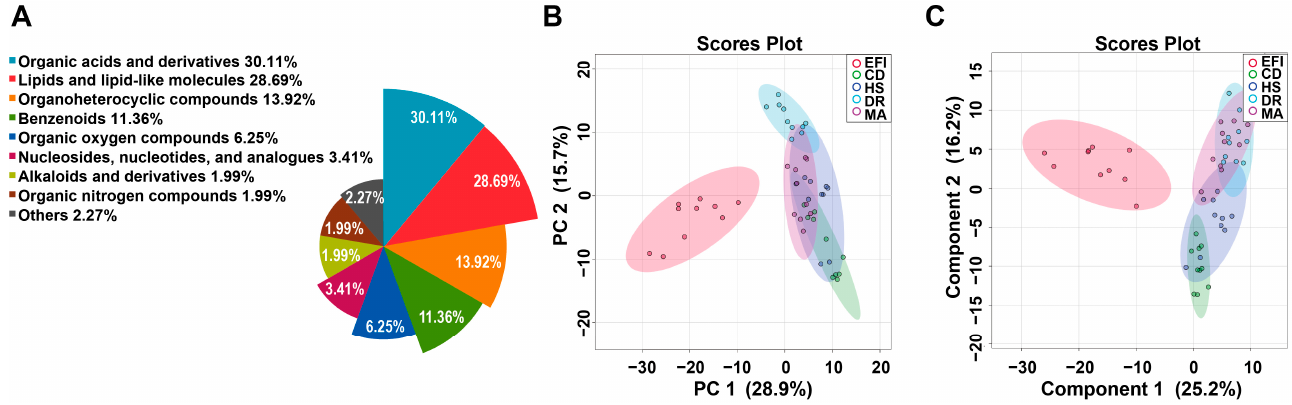
Figure 2. Overviews of the metabolic profiles of plasma samples in the EFI and NDRDs mice. NDRDs, including CD, DR, MA, and HS, are four animal models. n animal = 10, respectively. Total 50 samples in 5 groups. ( A ) Nightingale Rose Chart of metabolite classification. ( B ) Overview of metabolic profiles of the EFI and NDRDs groups using principal component analysis (PCA) score plot. ( C ) The partial least squares discriminant analysis (PLS-DA) score plot. Abbreviations: NDRD: non-drug related death, CD: cervical dislocation, DR: drowning, MA: mechanical asphyxia, HS: acute hemorrhagic